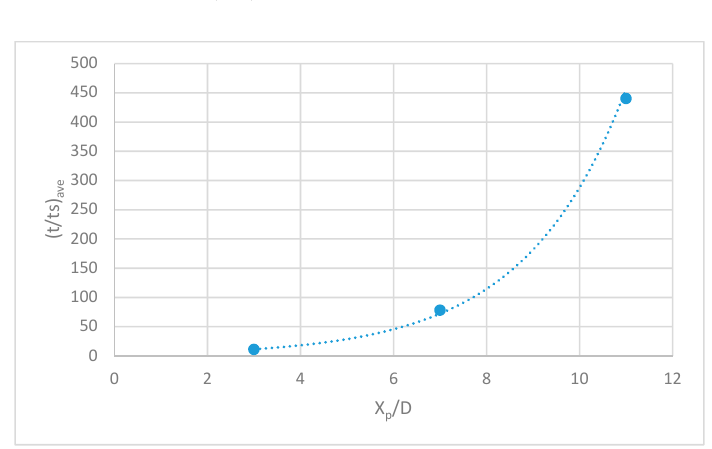
Figure 11. Effect of Purging Location on the Average Time of Removal Ratio to Achieve Complete TDS Removal.